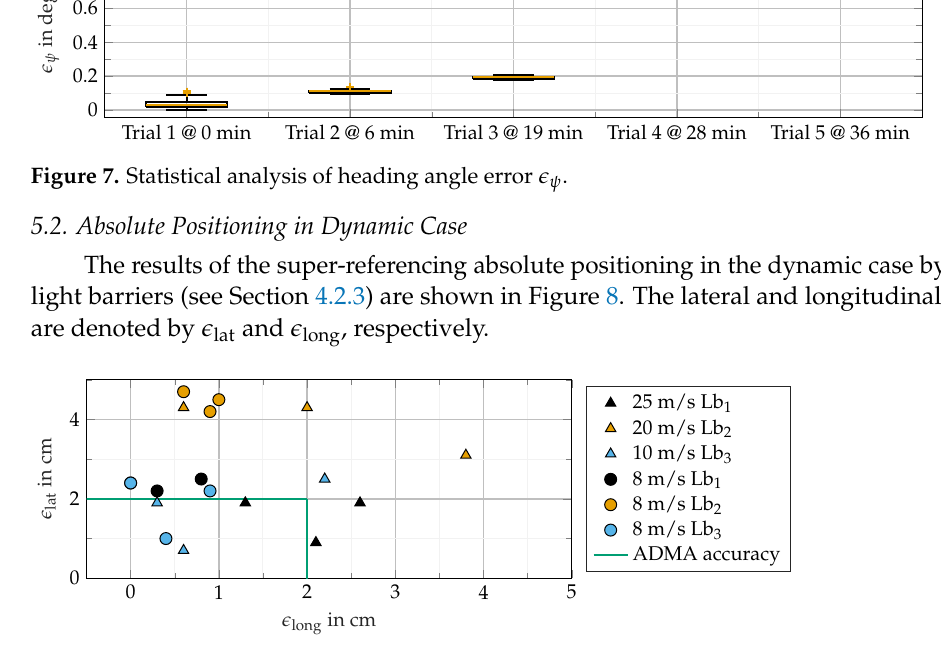
Figure 8. Lateral (cid:101) lat vs. longitudinal error (cid:101) long obtained by light barriers and